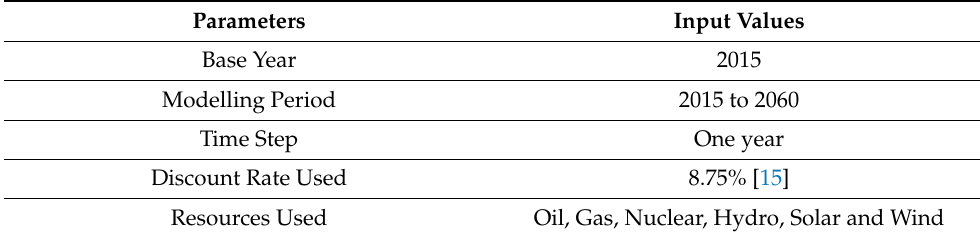
Table 1. Input parameters of the general tab in MESSAGE.